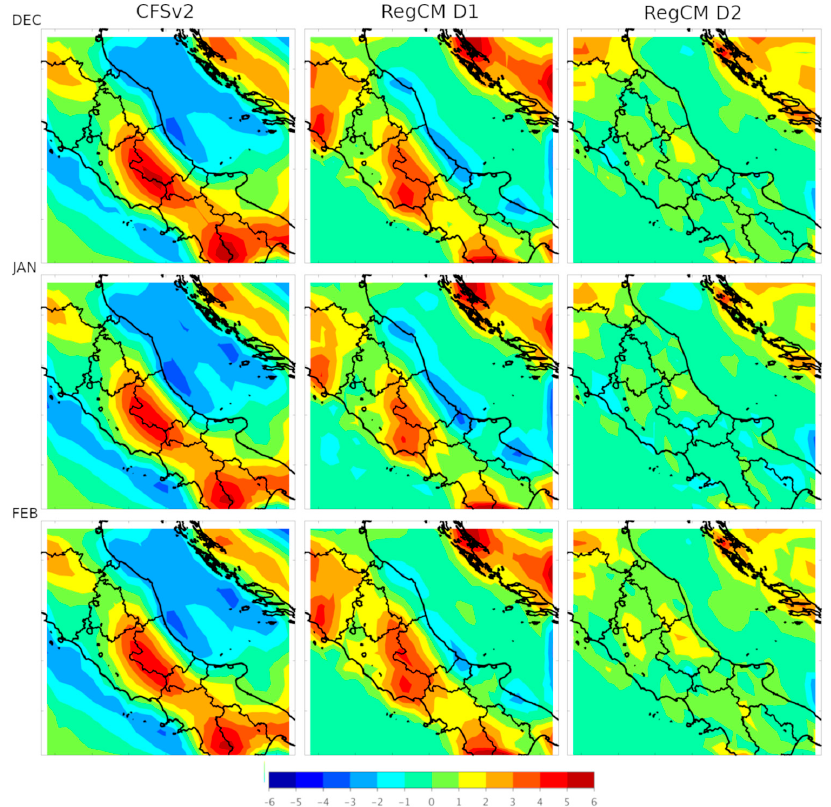
Figure 2. Climatological period (1982–2003 for December 1983–2004 for January and February) ensemble mean monthly mean temperature bias of the three forecasts products, compared to the reanalysis. Units are in °C.